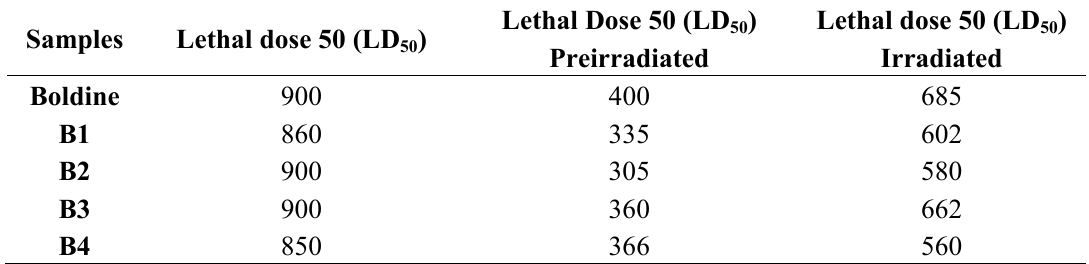
Table 3. Median lethal dose (LD ( B1 – 4 ) with the Artemia salina